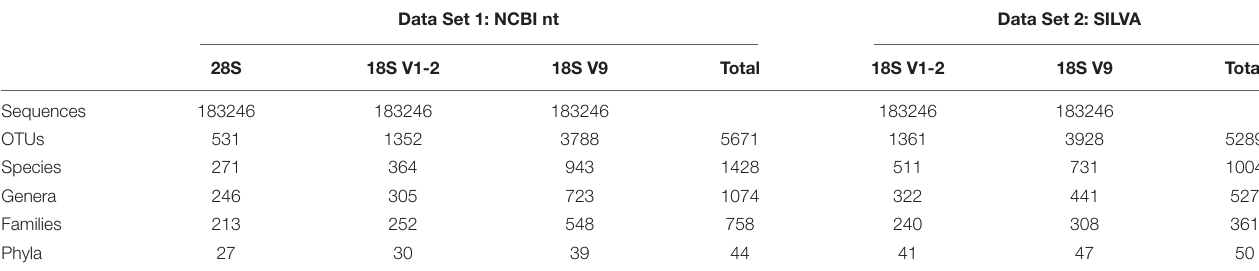
TABLE 3 | Summary of taxonomic assignment identified with different metabarcoding markers and different reference databases. Data Set 1: NCBI nt Data Set 2: